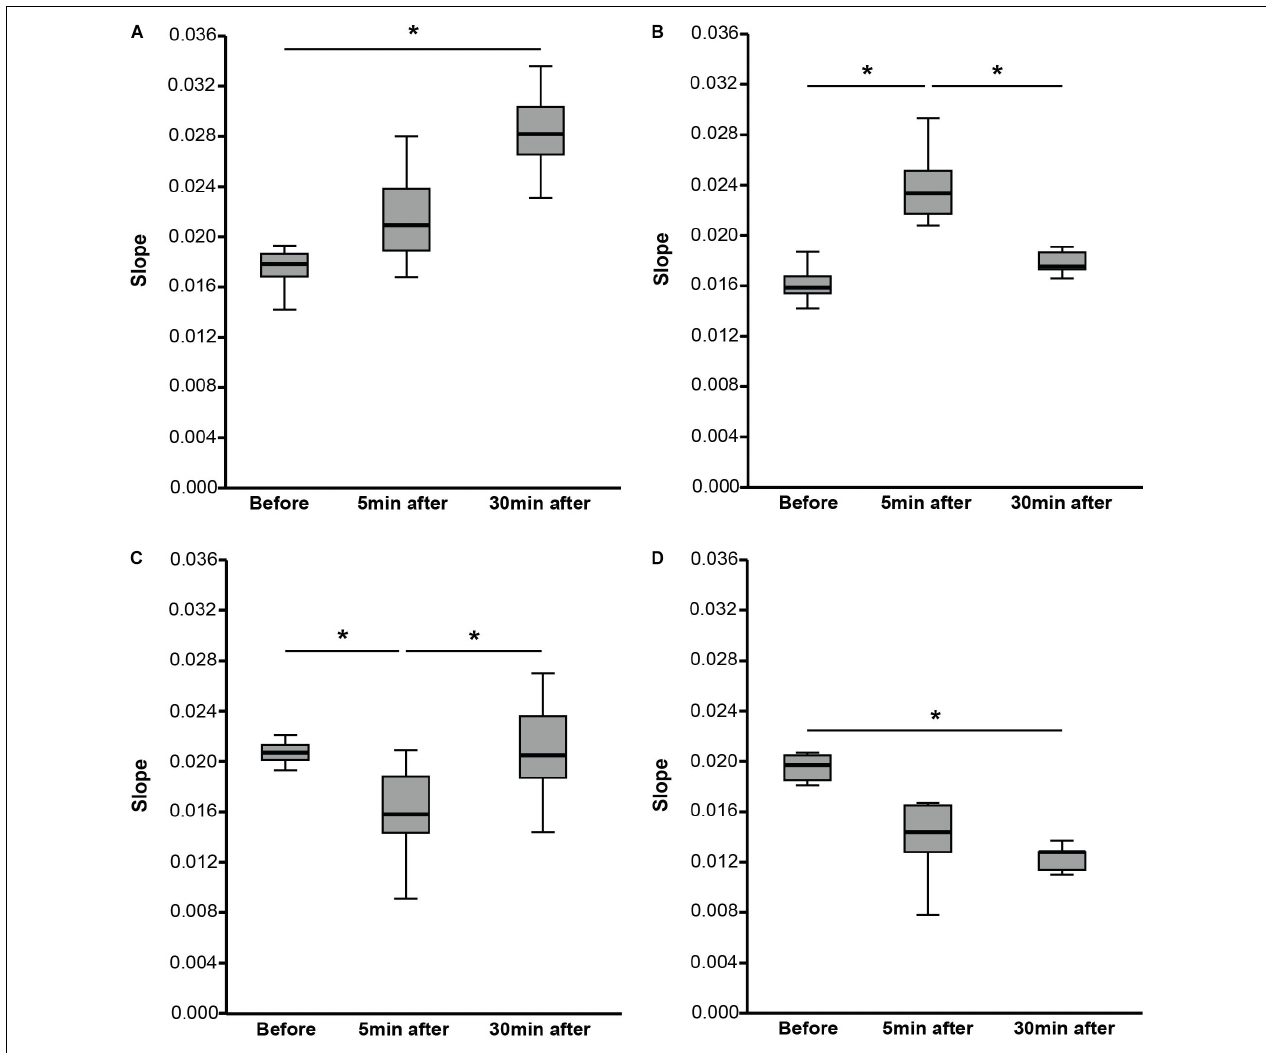
FIGURE 3 | Slope of recruitment curves (RCs) for before, 5 min after, and 30 min after PAS divided into four different response groups. (A) The participants ( N = 8) showed an increase of the slope from before to 5 min after PAS and to 30 min after PAS. (B) The participants ( N = 8) showed an increase of the slope from before to 5 min after PAS followed by a decrease of the slope from 5 to 30 min after PAS. (C) The participants ( N = 15) showed a decrease of the slope from before to 5 min after PAS followed by an increase of the slope from 5 to 30 min after PAS. (D) The participants ( N = 5) showed a decrease of the slope from before to 5 min after PAS and to 30 min after PAS. Data are median values (interquartile range) as indicated. The slope of the RC was calculated as the slope of the linear regression line through a supplied set of x-values (normalized motor-evoked potential values) and y-values (stimulation intensities). For each group, the slope comparisons of before, 5 min after, and 30 min after PAS were performed using Friedman test. Dunn–Bonferroni post hoc test was performed when a significant comparison was analyzed. ∗ p <